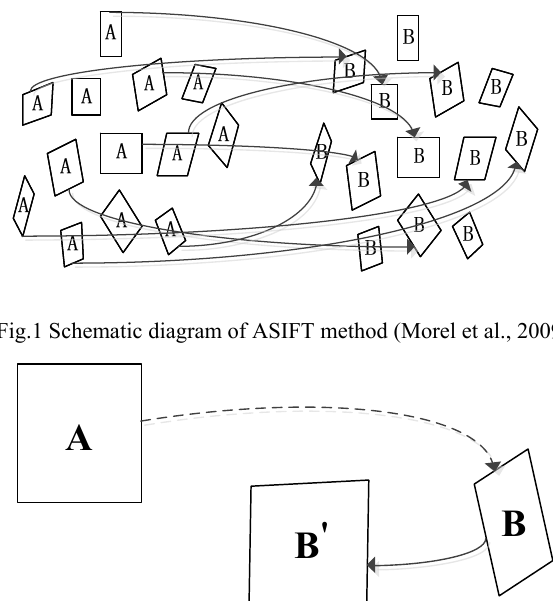
Fig.2 Schematic diagram of ISIFT method (Yu et al.,